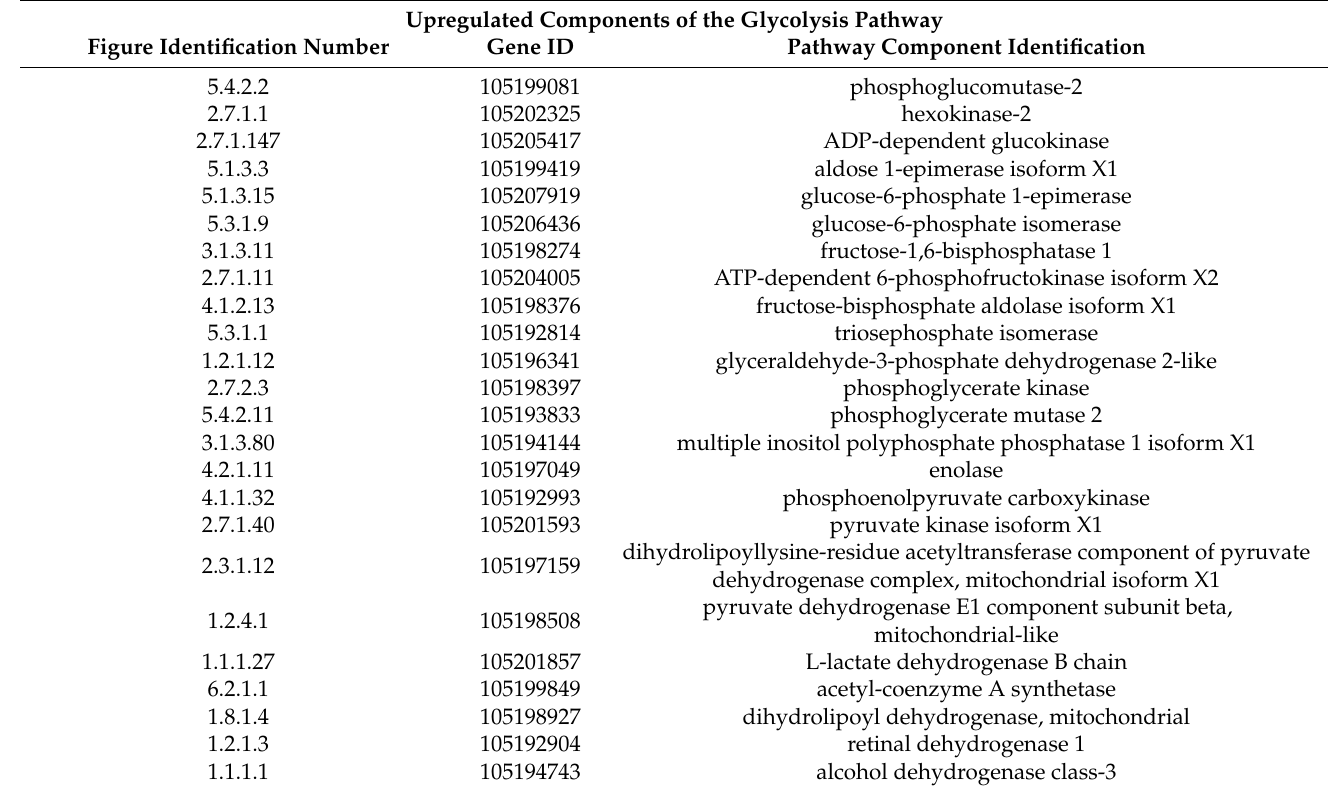
Table 2. Components of the glycolysis pathway that are upregulated in fire ants following SINV-3 infection, and their function in the glycolysis